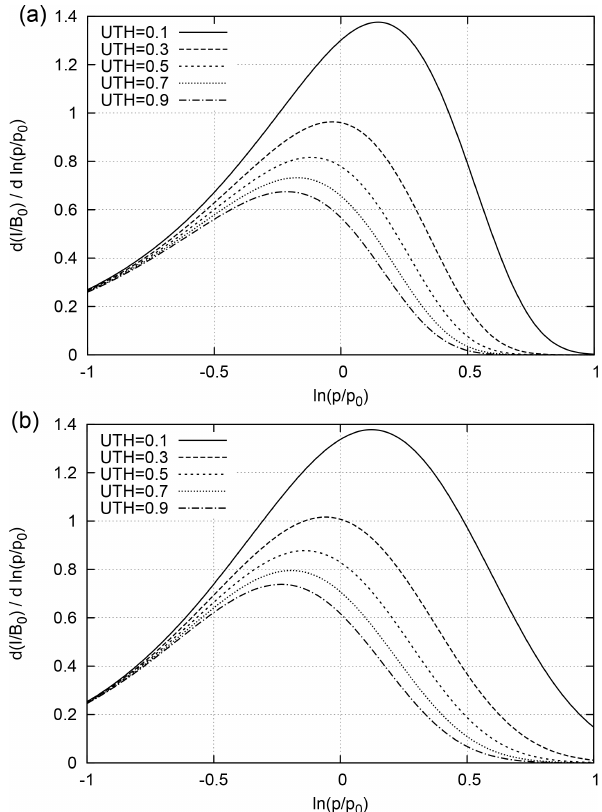
Figure 3. The function (normalised by the Planck function at T 0 ) to be integrated to get the radiance in channel 12 as a function of ln (p/p 0 ) shown for various values of the UTH: (a) using the first-order approximations of SB93; (b) using the second-order ap- proximations (this study). The higher the UTH, the less radiation is received at the satellite.